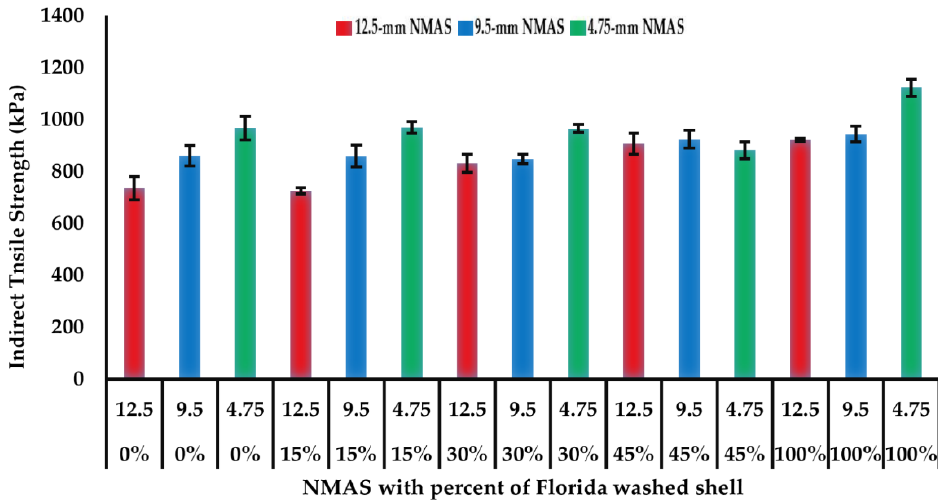
Figure 5. Indirect tensile strength results of open-graded asphalt mixtures at 25 C.